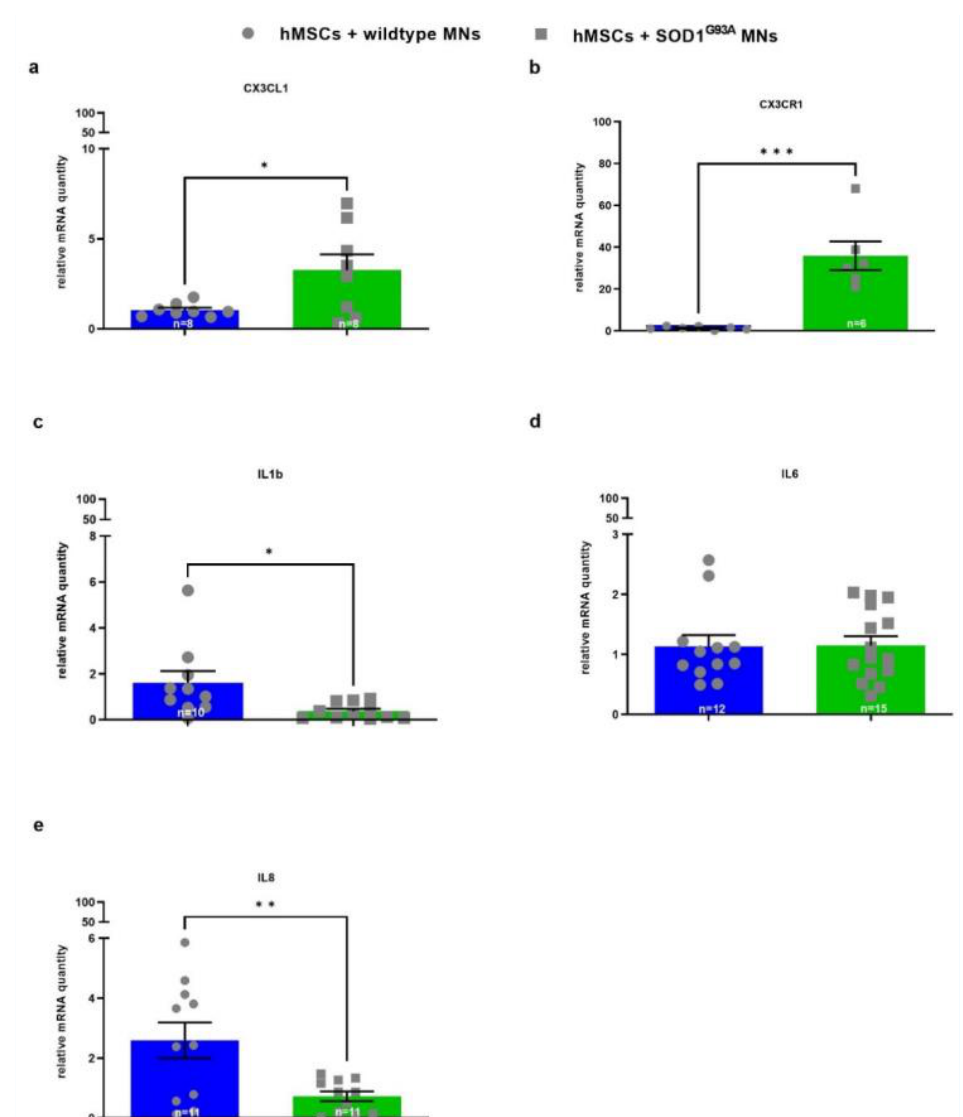
Figure 6. Altered mRNA levels of inflammatory cytokines/chemokines (CX3CL1, CX3CR1, IL1b and IL8) in hMSCs when co-cultured with wildtype or SOD1 G93A MNs. 10,000 wildtype or SOD1 G93A motor neurons were seeded on 10,000 hMSCs. After 5 DIV cells were lysed and mRNA was isolated and transcribed to cDNA. For real-time PCR 5 ng or 50 ng transcribed cDNA per sample were applied, respectively. Quantitative analysis was performed with Tubulin (for IL8), PPIA (for CX3CL1, CX3CR1 and IL1b, respectively) and b2M (for IL6) as housekeeping genes and expression patterns were analysed by comparative Ct method (2 − ∆∆ Ct ). ( a ) CX3CL1 mRNA levels ( n = 8). ( b ) CX3CR1 mRNA levels ( n = 6–7). ( c ) IL1b mRNA levels ( n = 10–11). ( d ) IL6 mRNA levels ( n = 12–15). ( e ) IL8 mRNA levels ( n = 11). Statistical analyses were performed with unpaired t test: * p < 0.05, ** p < 0.01 and *** p < 0.001. Single values are represented as repeated measurements together with mean ± SEM.